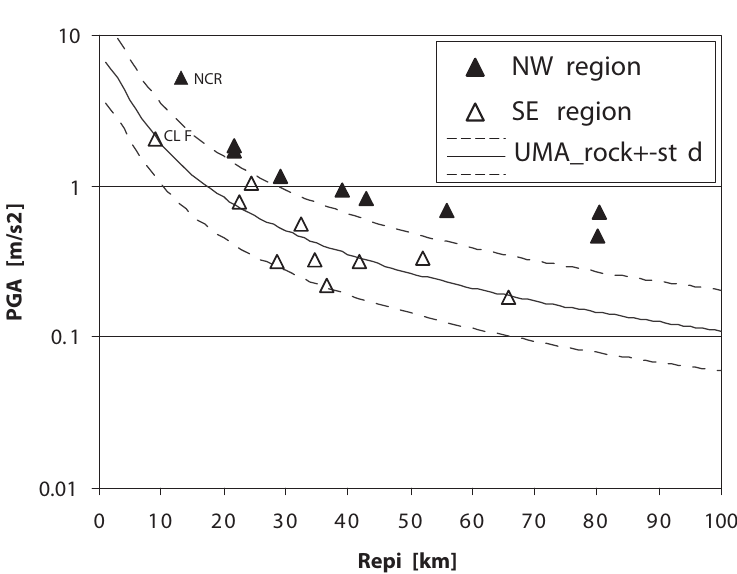
Fig. 1. Comparison of maximum horizontal PGAs recorded by accelerometers of the Italian Strong Motion Network with the UMA05 empirical predictive model of Bindi et al . (2006) for rock